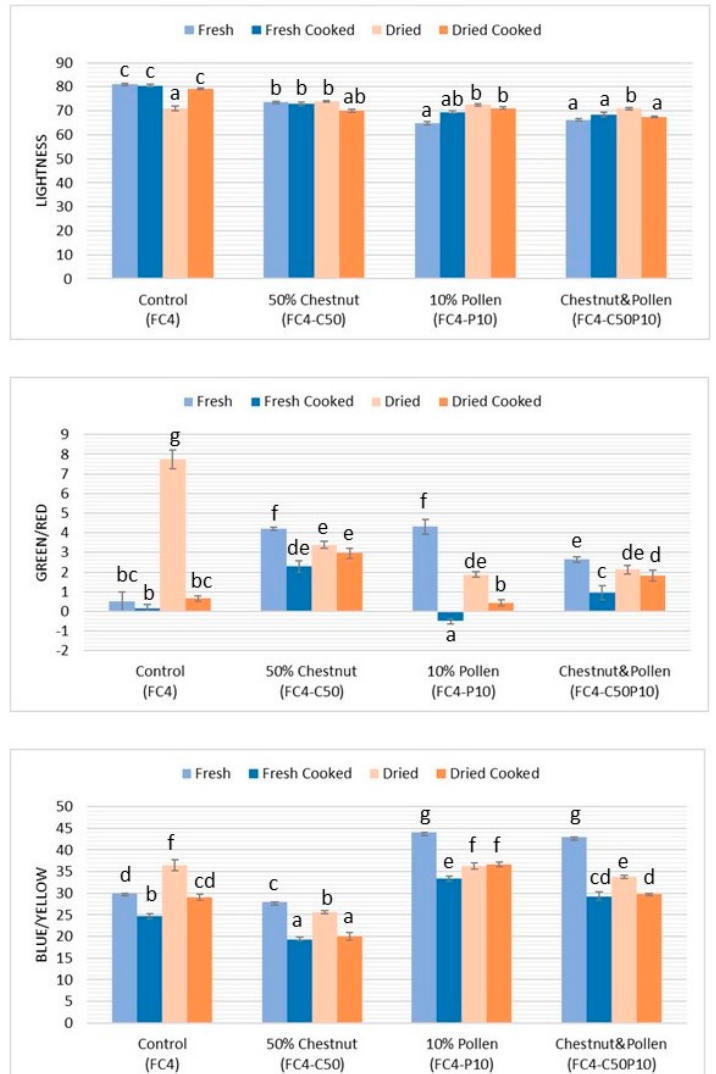
Figure 5. Color parameters of the pasta formulations developed. Statistical analysis: ANOVA with post-hoc Tukey’s test ( p < 0.05); bars with the same letter are not statistically different.